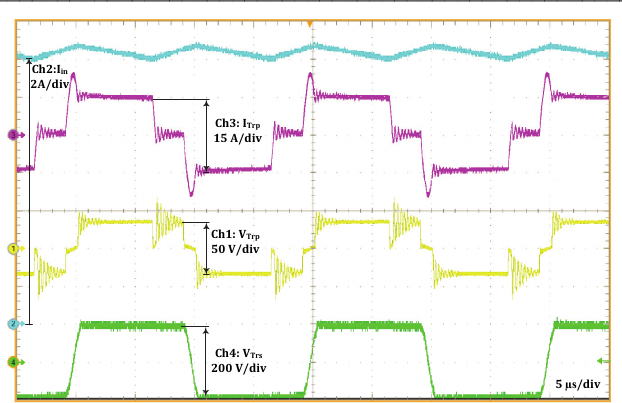
Fig. 6. Experimental waveforms of an ASMC converter: Ch1 – S1 gate voltage, Ch2 – S2 gate voltage, Ch3 – S1 current and Ch4 – S2 current.